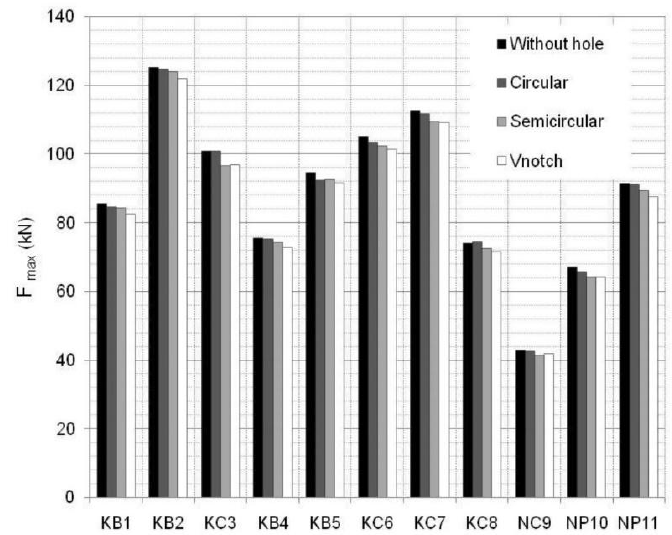
Figure 12. Comparison of maximum load for a 3% b 0 indentation.